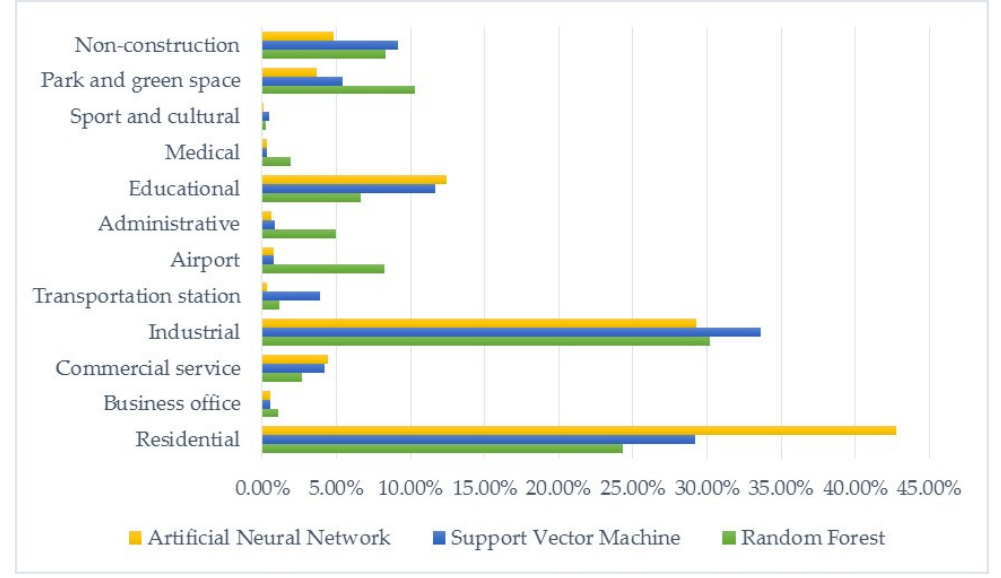
Figure 5. The area percentage of Level II land-use types in the mapping results.